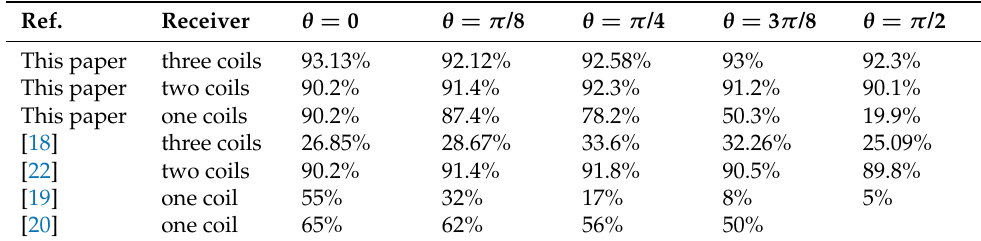
Table 3. Comparison of efficiency achieved in other papers.